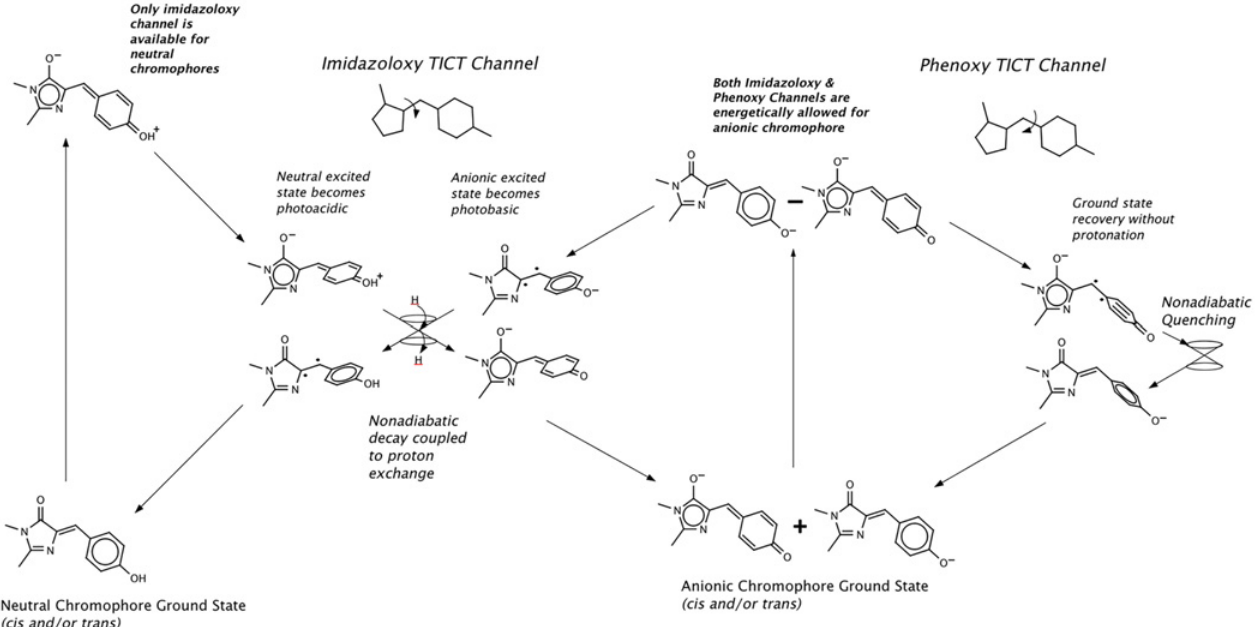
Fig 5. Decay via twisted internal charge-transfer states of the chromophore with mechanism for coupling to proton transfer. A schematic depiction of the hypothetical photoswitching mechanism. The mechanism is a variation of the photoswtiching mechanism for negative-mode reversibly photo switchable fluorescent proteins suggested by Olsen Lamothe & Martínez [62]. The key point is that there are two twisted intramolecular charge-transfer channels available to the anionic chromophore, whose ground state is a quantum superposition of states with distinct bond alternation. The excited state is the anti-phase combination of the same two bonding states. The two channels correspond to the two bonds on the bridge. The neutral chromophore only has one TICT channel, corresponding to the I bond, reflecting the definite bond alternation of its ground state. The neutral excited state has opposing bond alternation and charge localisation, relative to its ground state. If the anionic chromophore accesses the imidazolinone TICT channel, then its excited state becomes photo basic relative to the optically excited state, increasing the probability that it will accept a proton. Acceptance of a proton by the anion TICT state in the imidazolinone channel deactivates the excited state, yielding a neutral chromophore population in its ground state. If the anion accesses the phenoxy TICT channel in its excited state, electron density is pushed off the phenoxy, making it more photo acidic than the optically prepared excited state, and preventing proton uptake. Deactivation of the anionic excited state can still occur through the conical intersections that exist in the phenoxy TICT channel, yielding an anionic ground state. If the combined rate of access of the phenoxy and imidazolinoxy channels is much larger than the rate of fluorescence, then the "ON" state is non-fluorescent, as observed in Phanta. The kinetics of photoswitching will depend on the precise shape of the electronic state surfaces and on the friction experienced by the chromophore during its excited-state dynamics. The coupling between TICT state channels and protonation state can be understood using an adaptation of a two-state electron transfer model